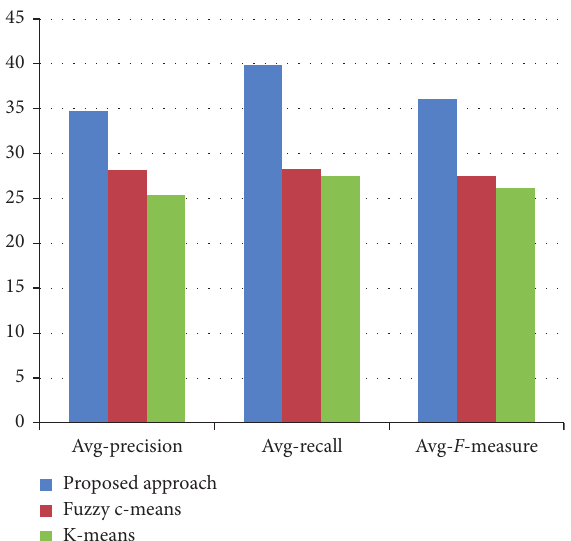
Figure 2: Evaluation of summarization models in respect of ROUGE-1 measures on Ubuntu dataset.